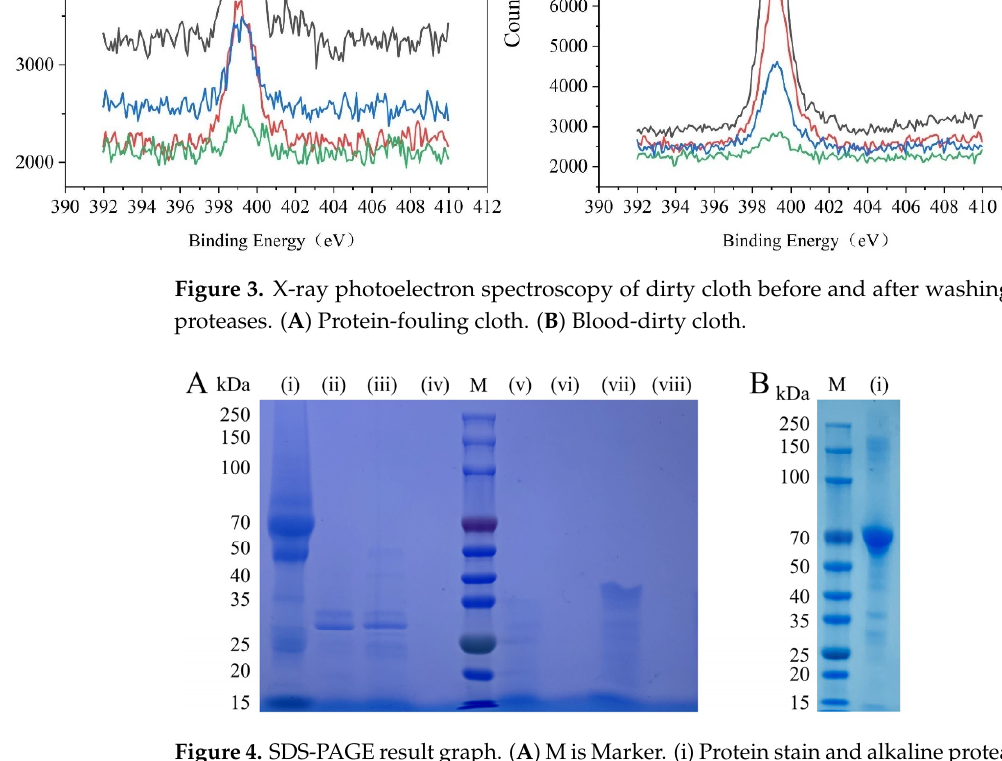
Figure 4. SDS-PAGE result graph. ( A ) M is Marker. (i) Protein stain and alkaline protease. (ii) Alkaline protease and double-distilled water. (iii) Protein stain and keratinase. (iv) Keratinase and double-distilled water. (v) Protein stain and alkaline protease and keratinase. (vi) Alkaline protease and keratinase and double-distilled water. (vii) Protein stain and trypsin. (viii) Trypsin and double-distilled water. ( B ) M is Marker. (i) Protein stain.